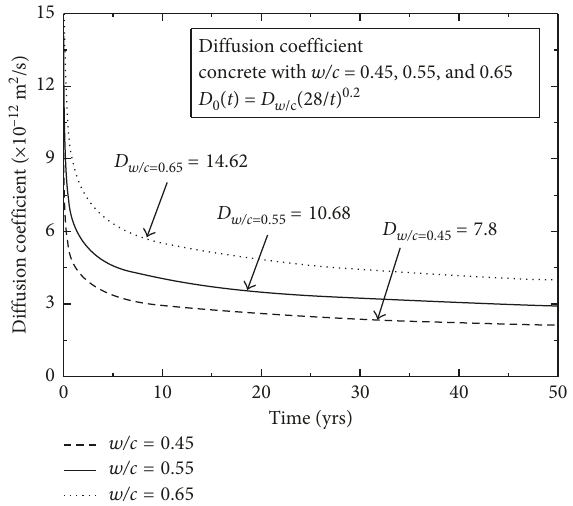
Figure 2: Time-dependent surface